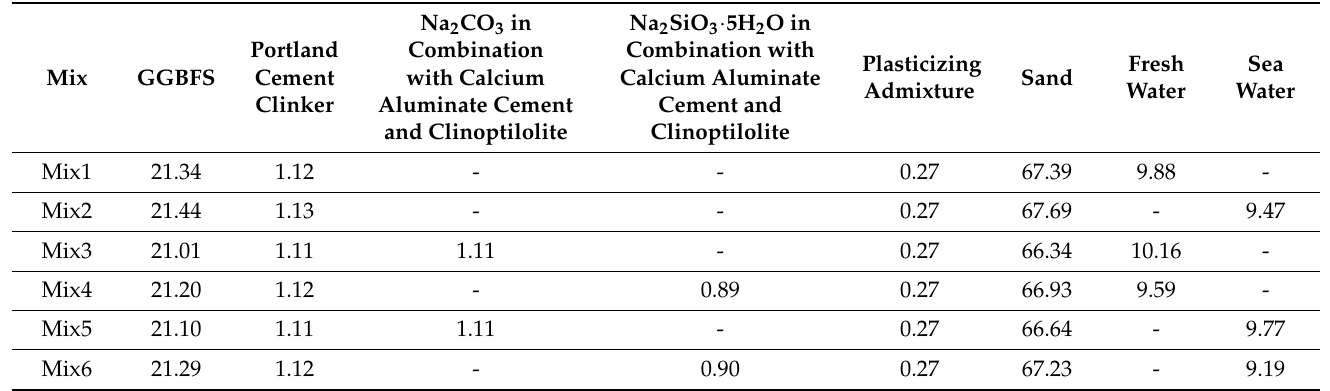
Table 2. The blast furnace cement concrete mix design (% by